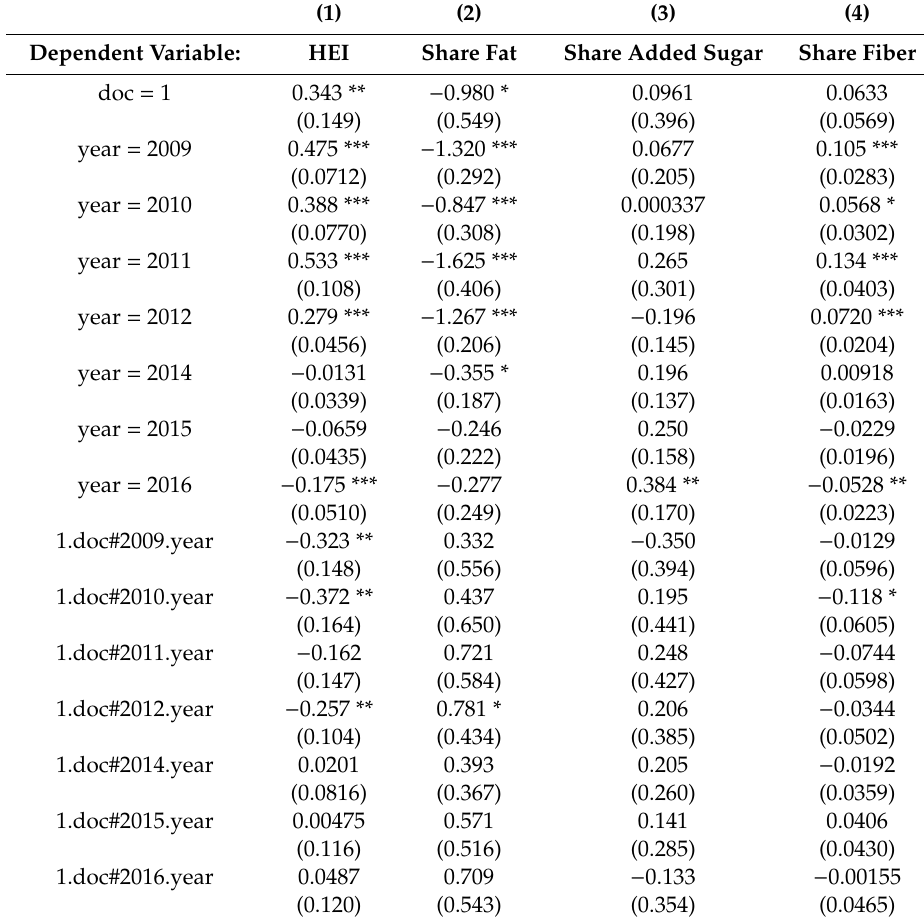
Table A6. Test of common trend of DoC switchers and